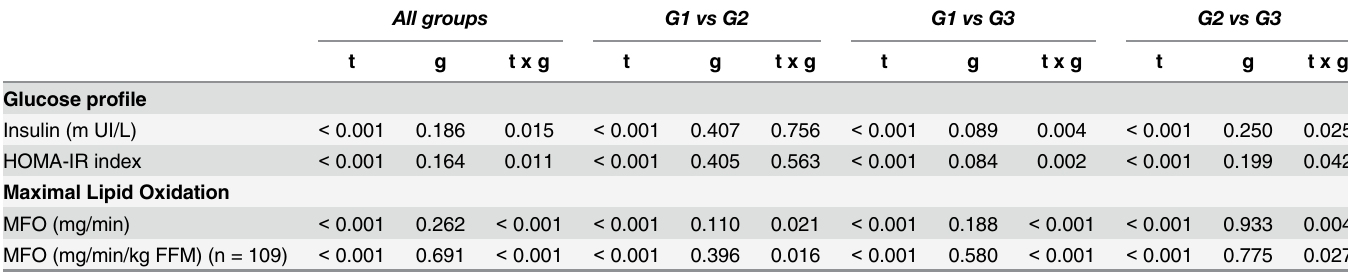
Table 5. Post-hoc analysis (Repeated – measures ANOVA P values) for longitudinal evolution of metabolic characteristics (month-0, month-3 and